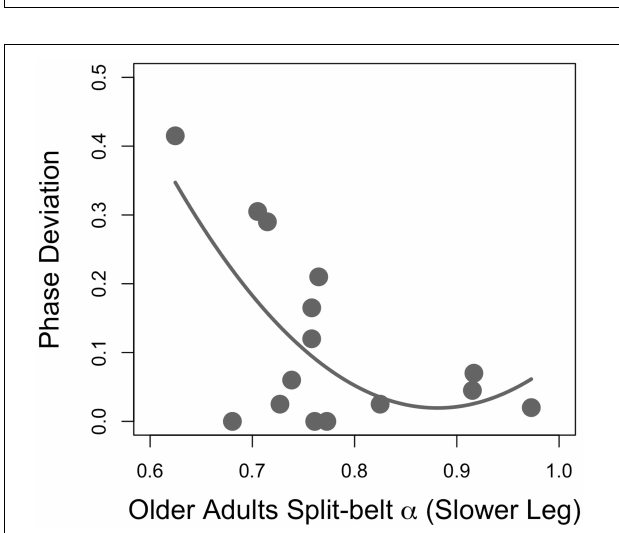
FIGURE 3 | Gait adaptation (Phase Deviation) versus the slower-moving leg’s fractal scaling during asymmetric (split-belt) walking in older adults.